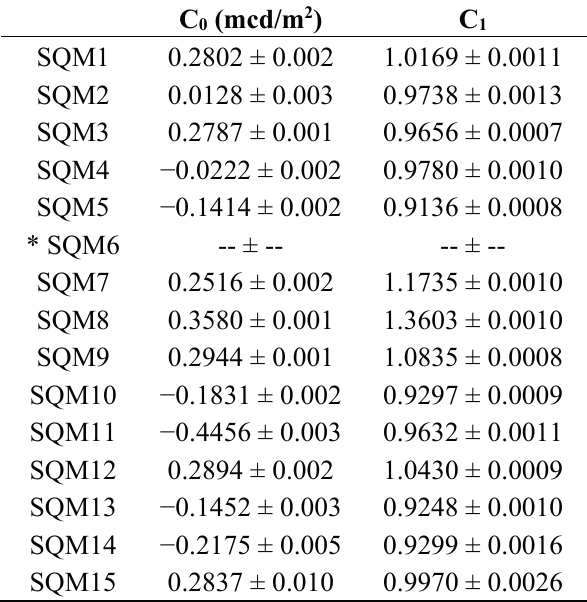
Table 2. Inter-calibration coefficients for offset C 0 and slope C 1 as first